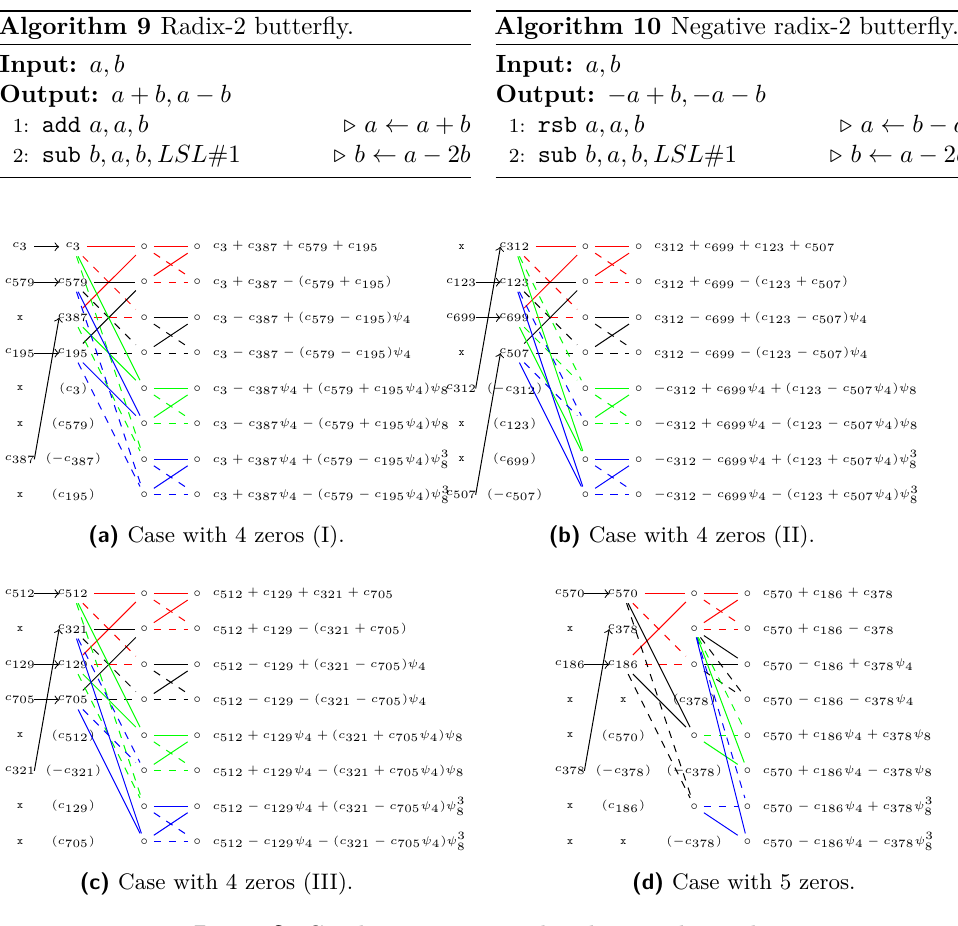
Figure 2: Goods permutation plus the initial